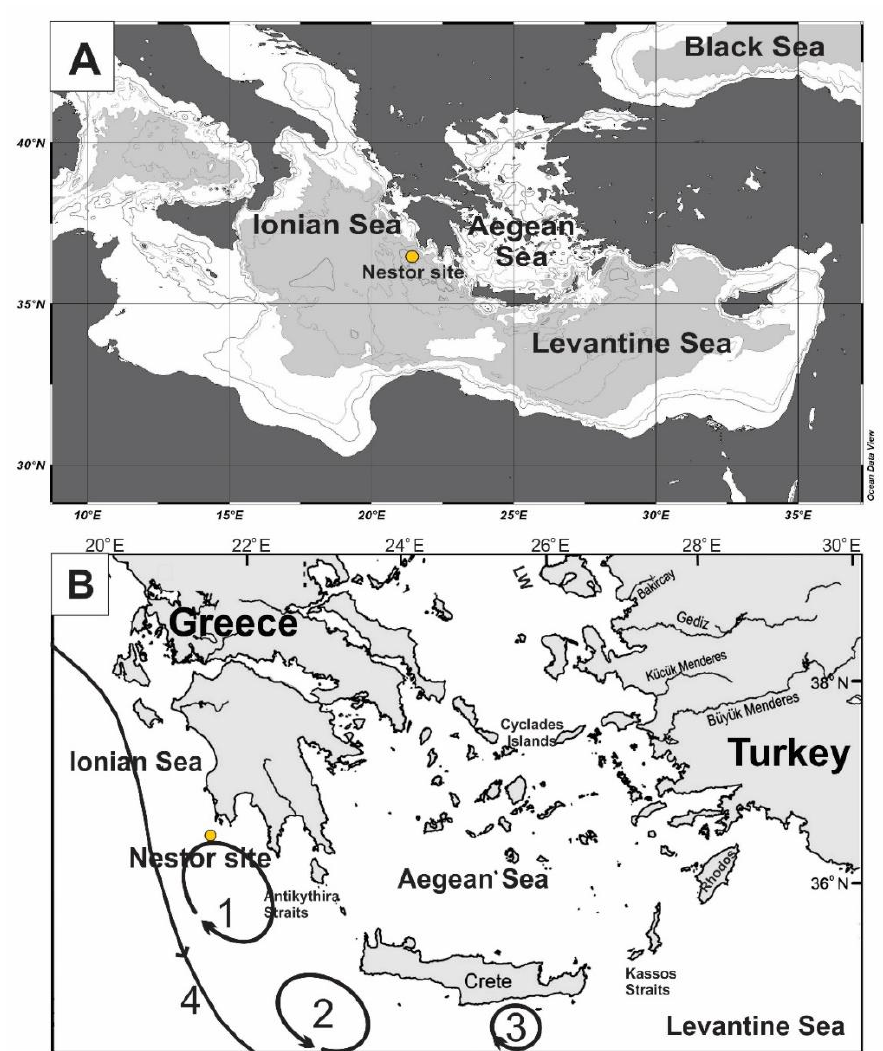
Figure 1. ( A ). Location of sampling site (Nestor site) in the SE Ionian Sea (Eastern Mediterranean Sea), ( B ). General circulation pattern in top 500 m (1. Pelops anticyclone, 2. Cretan cyclone, 3. Ierapetra anticyclone, 4. Atlantic – Ionian stream).